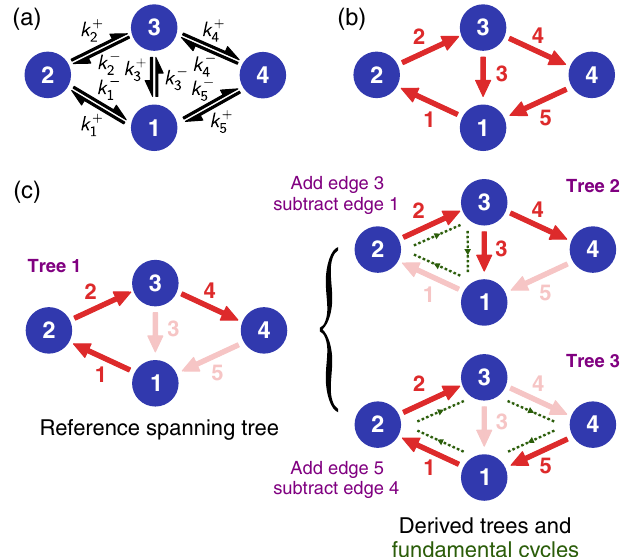
FIG. 3. A two-loop discrete state Markov model, with N ¼ 4 states and E ¼ 5 edges. (a) The black arrows correspond to entries in the transition matrix Ω ð λ t Þ : transition rates k (cid:2) i ð λ t Þ that depend on an external protocol λ t . (b) The red arrows labeled α correspond to the oriented stationary currents J α ð λ t Þ , defined in Eq. (13). (c) On the left, one of the spanning trees of the graph, chosen to be a reference for constructing the tree basis. Edges deleted to form the tree are shown in faint red. On the right, two trees in this set derived from the reference tree. Each such derived tree has a one-to-one correspondence with a fundamental cycle of the graph (highlighted in